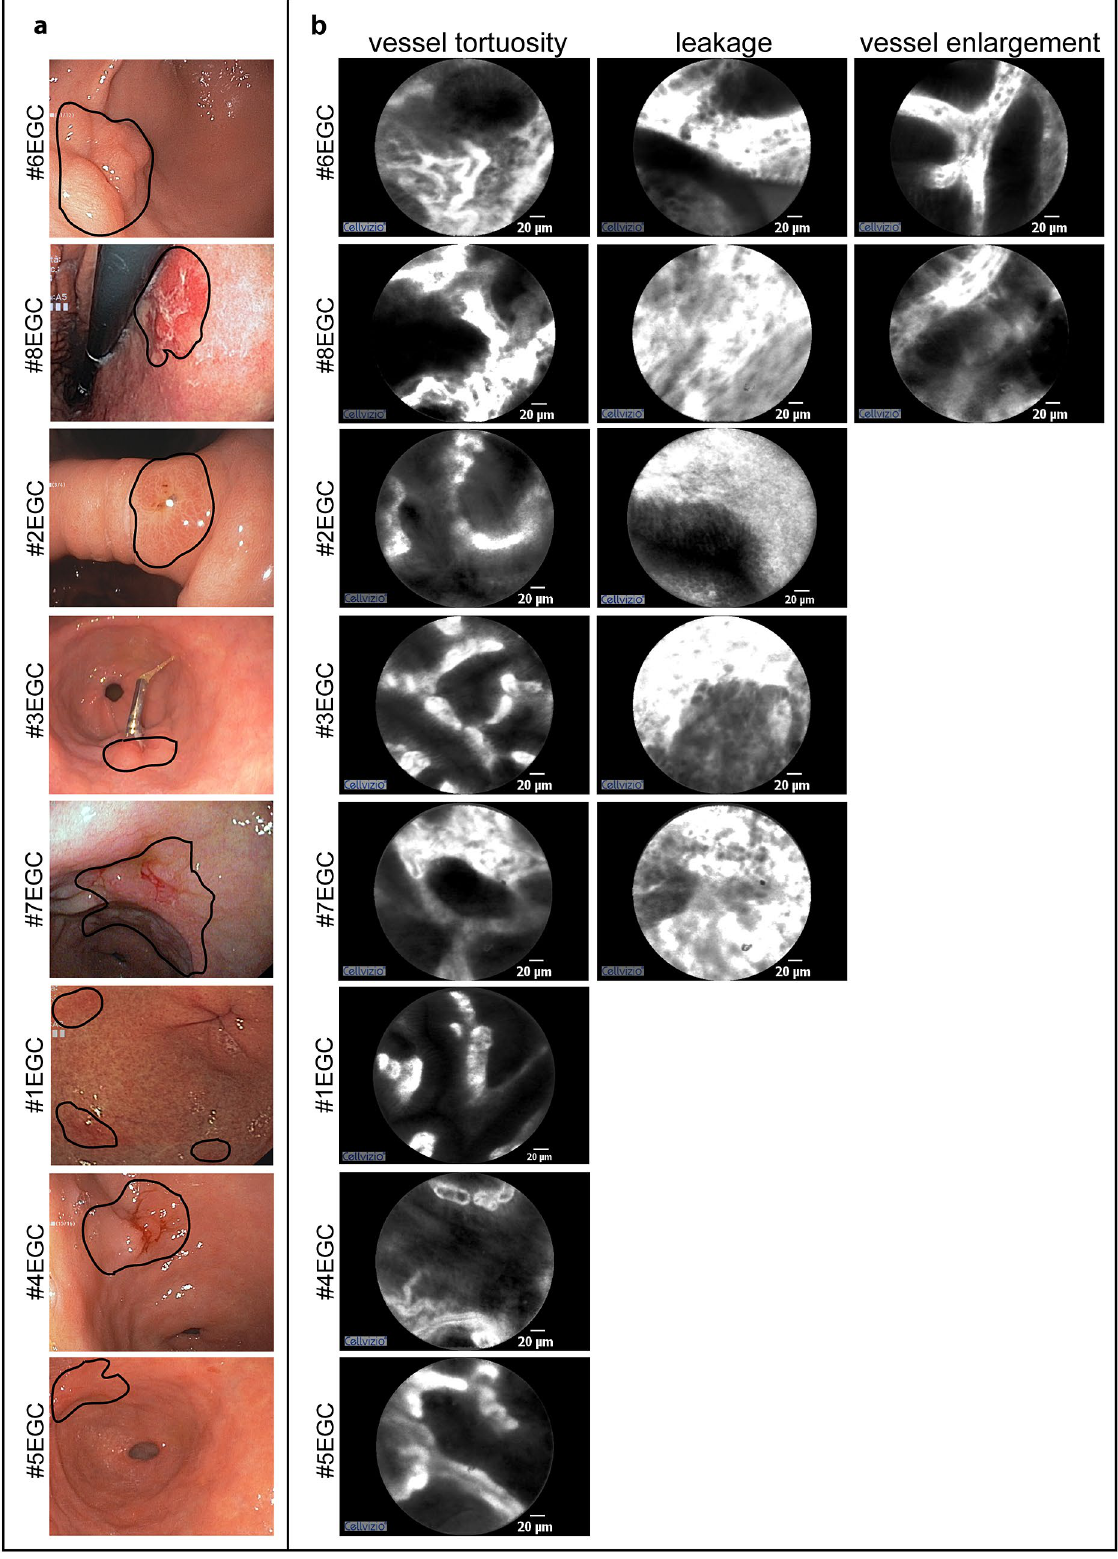
Figure 5. Endoscopic ( a ) and pCLE evaluation ( b ) in early gastric cancer (EGC) patients. The areas chosen for a diagnostic workup in endoscopic images are highlighted by a black line. The representative images of the vascular alterations for each patient are reported in b